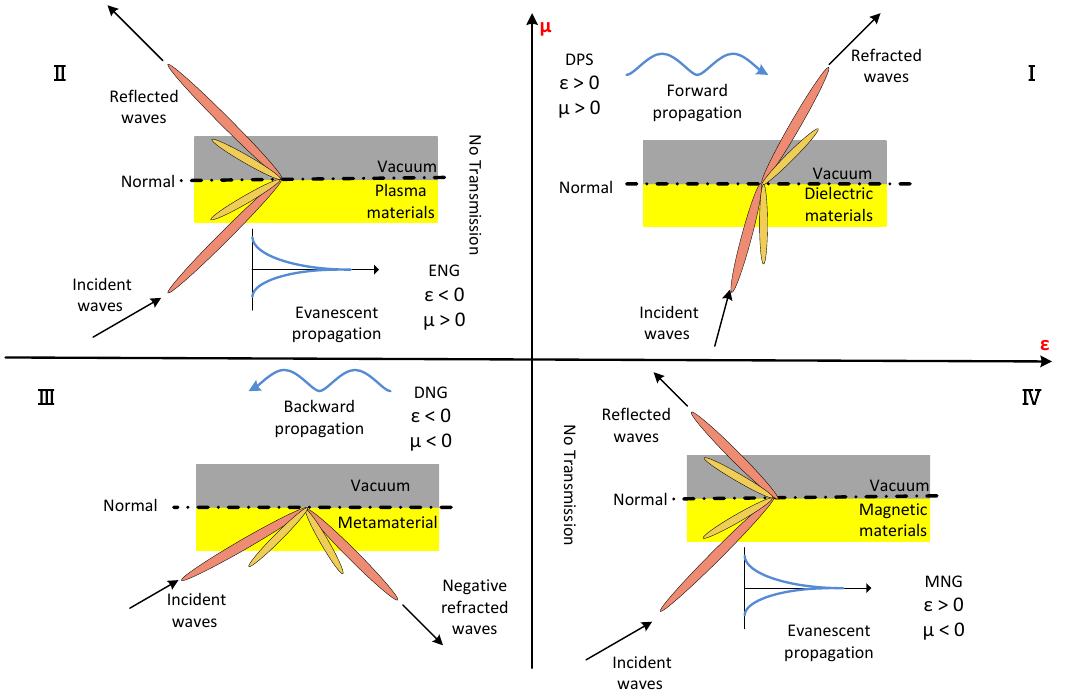
Figure 2. ( I – IV ) Metamaterial classifications based on permittivity and permeability